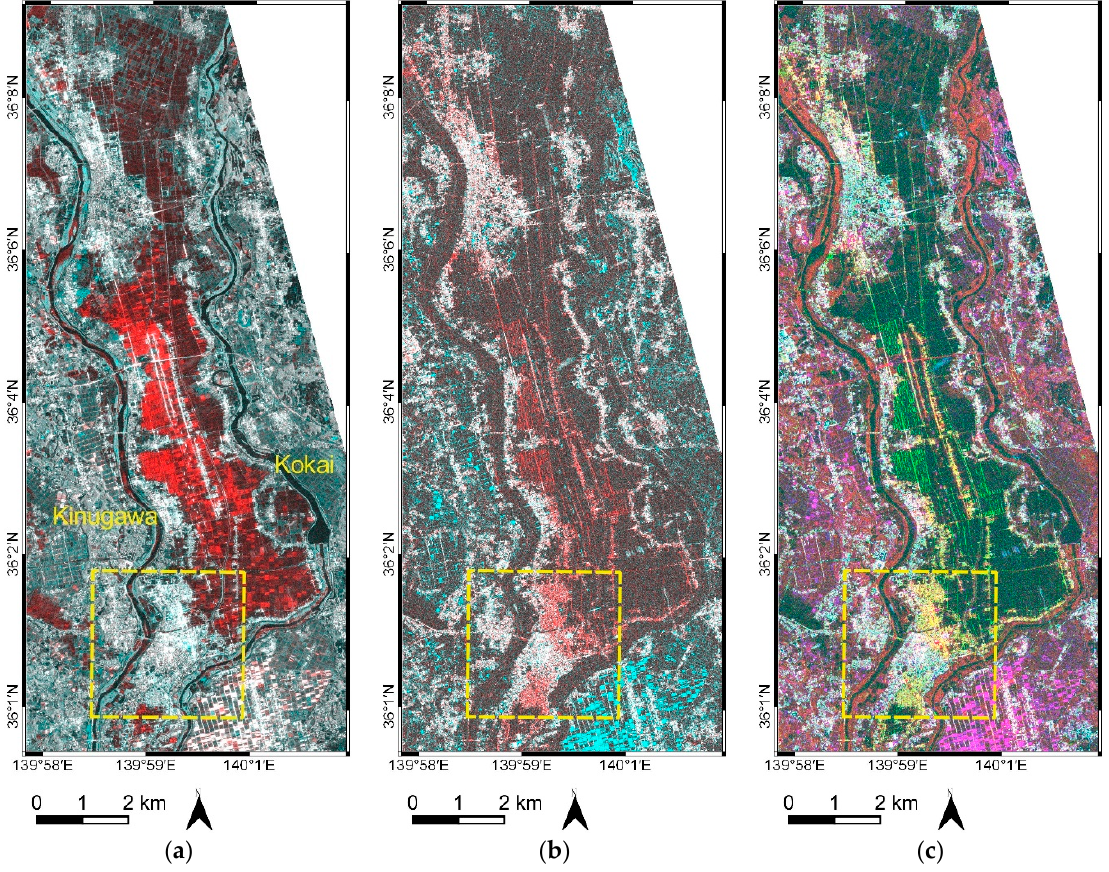
Figure 5. RGB color composites of the Joso case study: ( a ) Intensity RGB composite, R = σ ° of July 31, 2015, G = B = σ ° of September 11, 2015; ( b ) Coherence RGB composite, R = γ of February 13–July 31, 2015, G = B = γ of July 31–September 11, 2015; ( c ) Intensity and coherence RGB composite, R = σ ° of